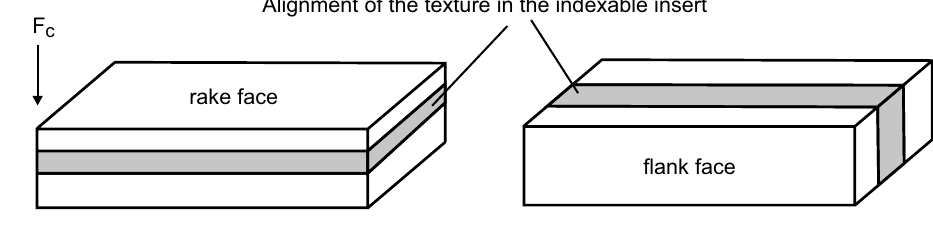
Alignment of the texture in the indexable